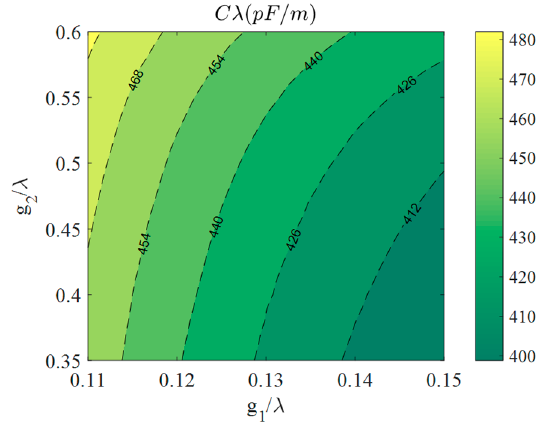
Figure A6. Contour of normalized capacitance as a function of g 1 and g 2 .